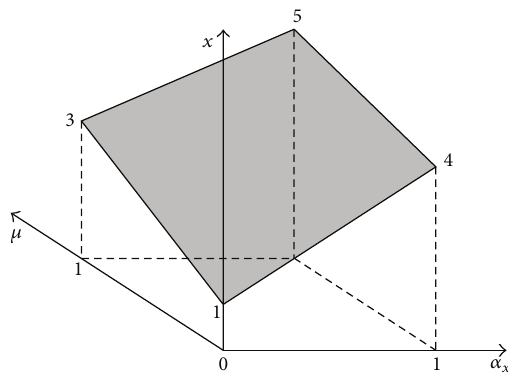
Figure 3: The horizontal membership function 𝑥 = ( 1 + 2 𝜇) + ( 4 − 3 𝜇)𝛼 𝑥 , where 𝛼 𝑥 ,𝜇 ∈ [ 0 , 1 ] , corresponding to the function from Figure 2, in the 3D space as the unambiguous